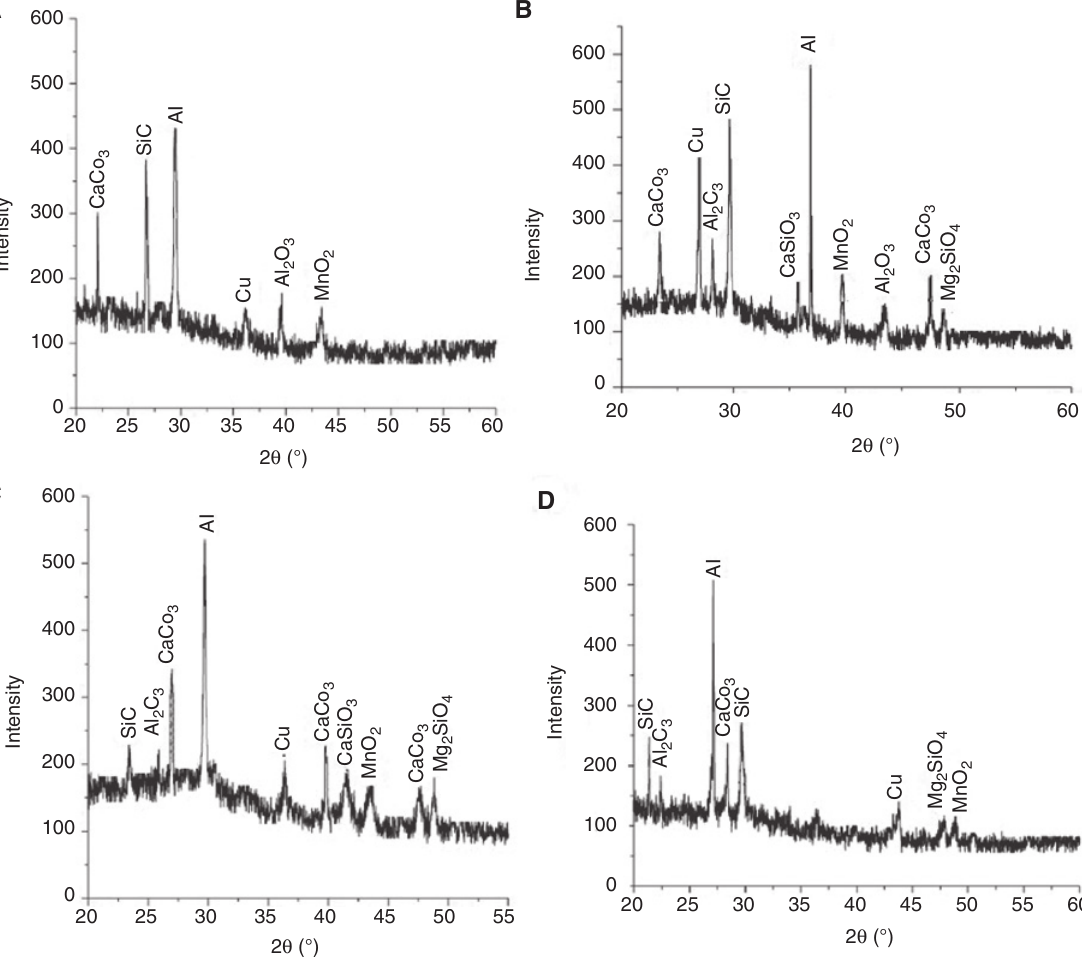
Figure 6: XRD results of (A) sample designation G1, (B) sample designation G3, (C) sample designation G5, and (D) sample designation and